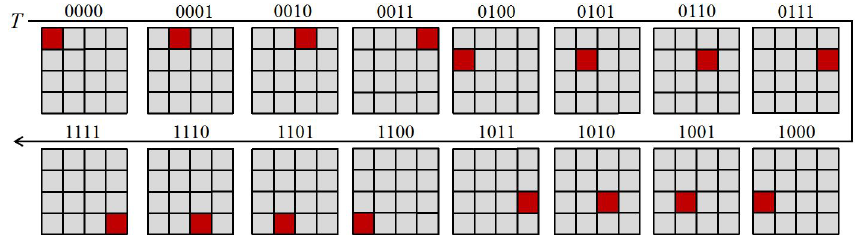
Figure 7. Example to illustrate the robot’s emotion transition from “anger” to “relaxation”.